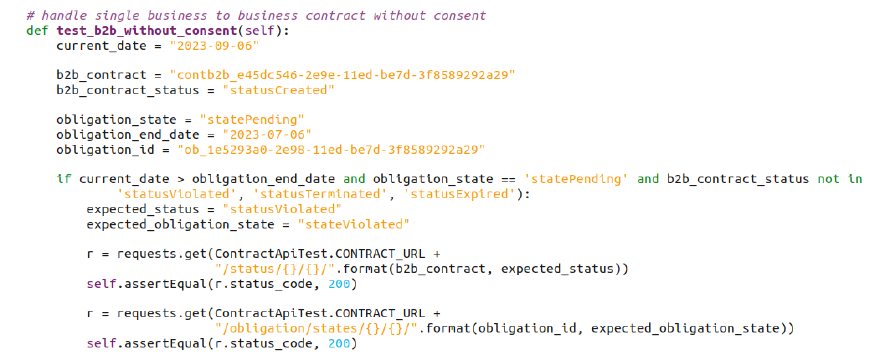
Figure 16. A unit test code snippet for B2B test scenario to check the CCV